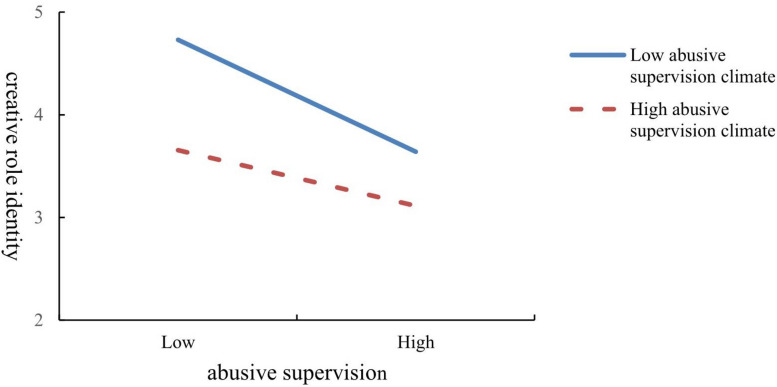
Interactive effect of abusive supervision climate and abusive supervision on creative role identity.